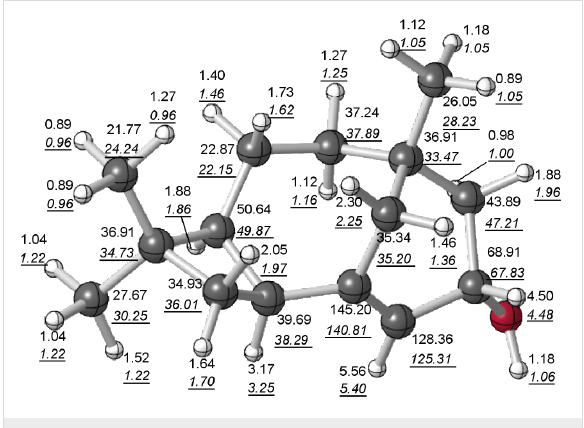
Figure 2: Computed (top) and experimental (bottom, underlined italics) [2] 1 H and 13 C chemical shifts for 1 (lowest-energy conformer found); see Experimental for